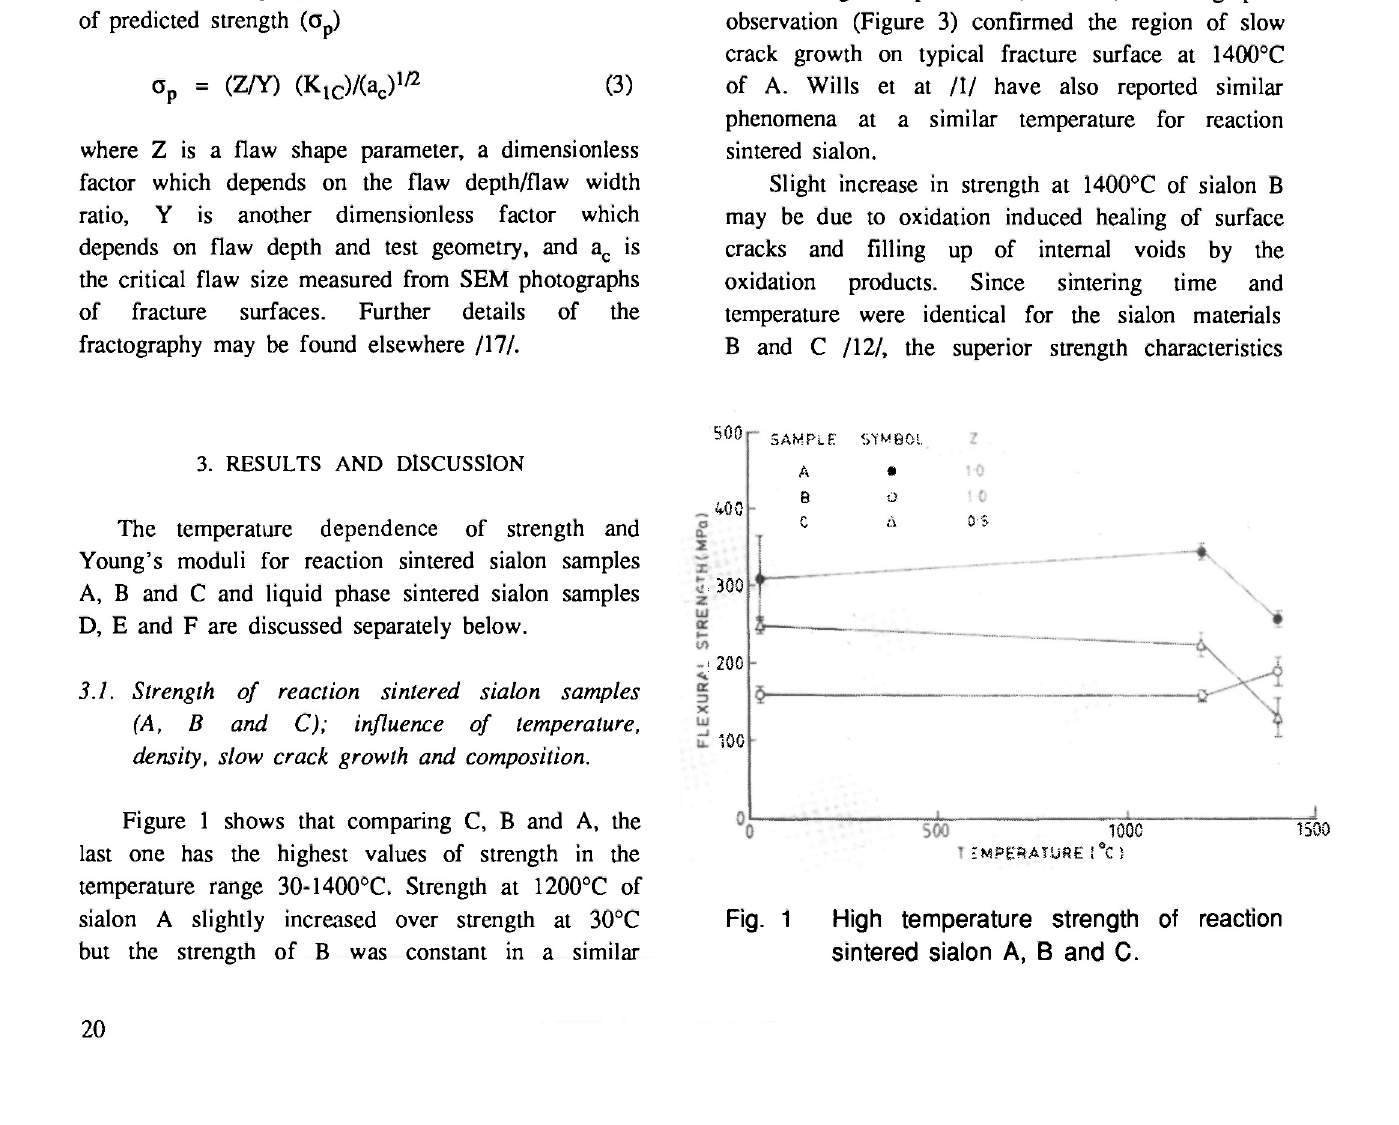
High temperature strength of reaction sintered sialon A, Β and